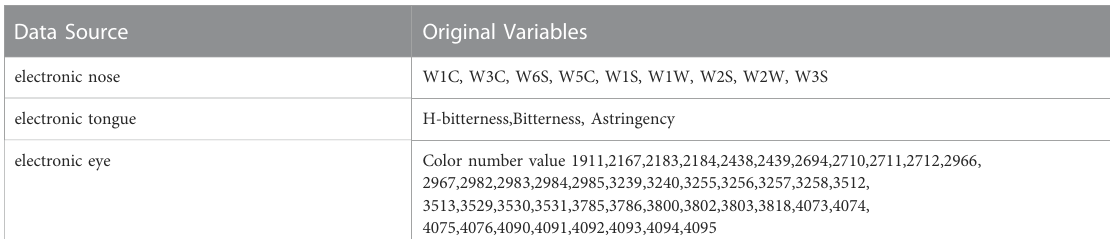
TABLE 2 Selected variables for electronic nose, electronic tongue and electronic eye.